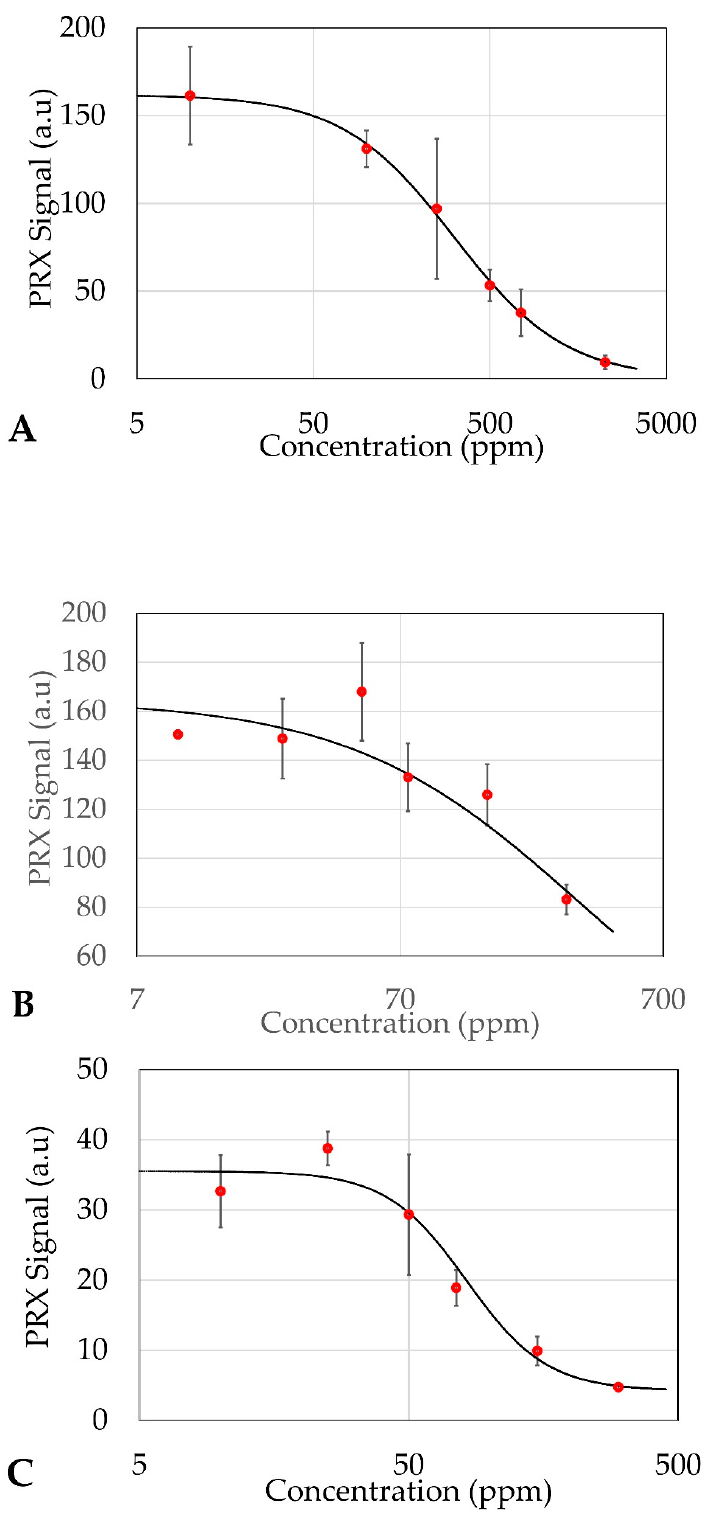
Figure 4. Calibration curves for the antibodies anti-deoxynivalenol ( A ), anti-T-2/HT-2 toxins ( B ), and anti-zearalenone ( C ). The semi-log graphs show the dose-response curve made with artificially contaminated samples prepared from an uncontaminated wheat flour spiked with determined amounts of mycotoxin standards. Error bars for each calibration point are reported.